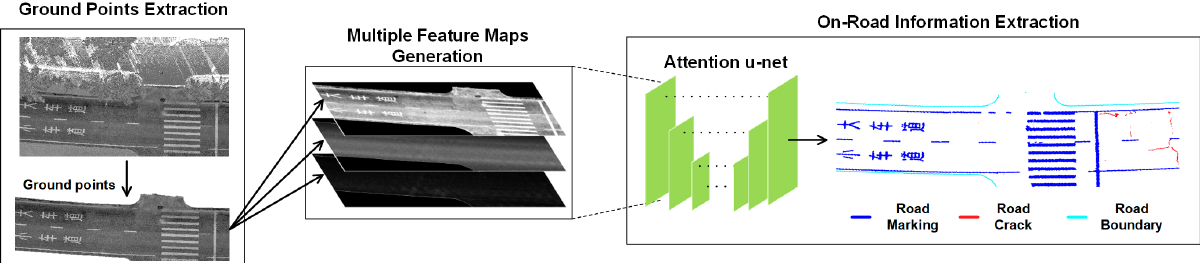
Figure 2. Framework of our proposed